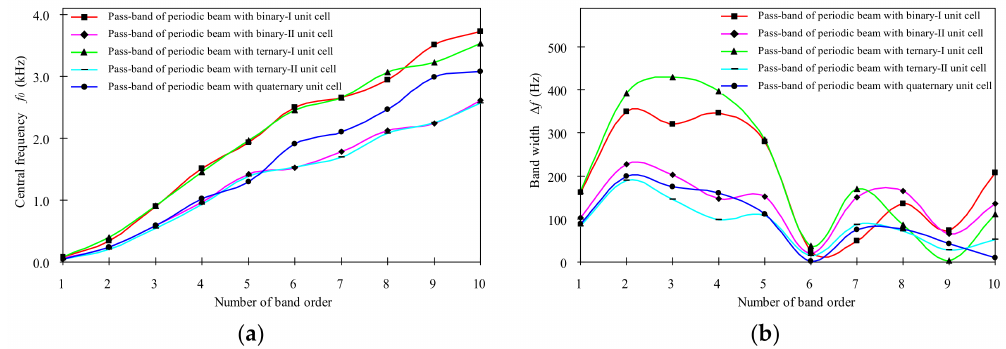
Figure 14. The contrast of the first 10 pass-bands properties for the five exemplified bi-coupled periodic multi-component beams. ( a ) the central frequencies; ( b ) the frequency